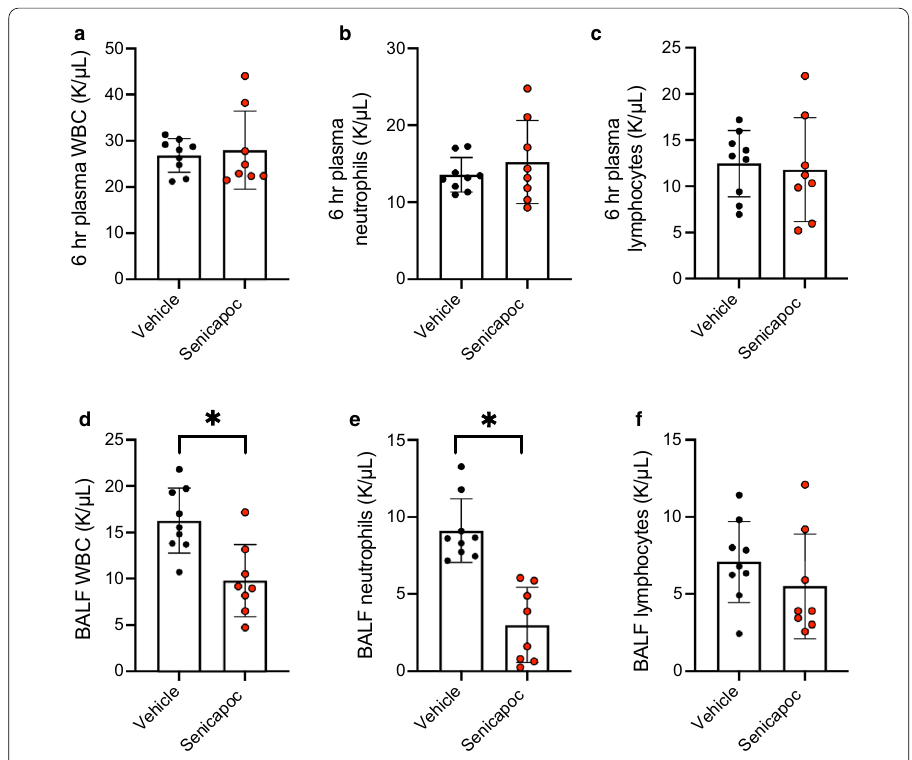
Fig. 4 Administration of senicapoc reduces levels of BALF white blood cells and neutrophils. Cell counts of a plasma white blood cells at 6h; b plasma neutrophils at 6h; c plasma lymphocytes at 6h; d BALF white blood cells; e BALF neutrophils and f BALF lymphocytes. Data are presented as mean SD. * P < 0.05 for senicapoc ± against vehicle. Vehicle, n 9 and senicapoc, n 8. BALF, bronchoalveolar lavage fluid; WBC, white blood = =